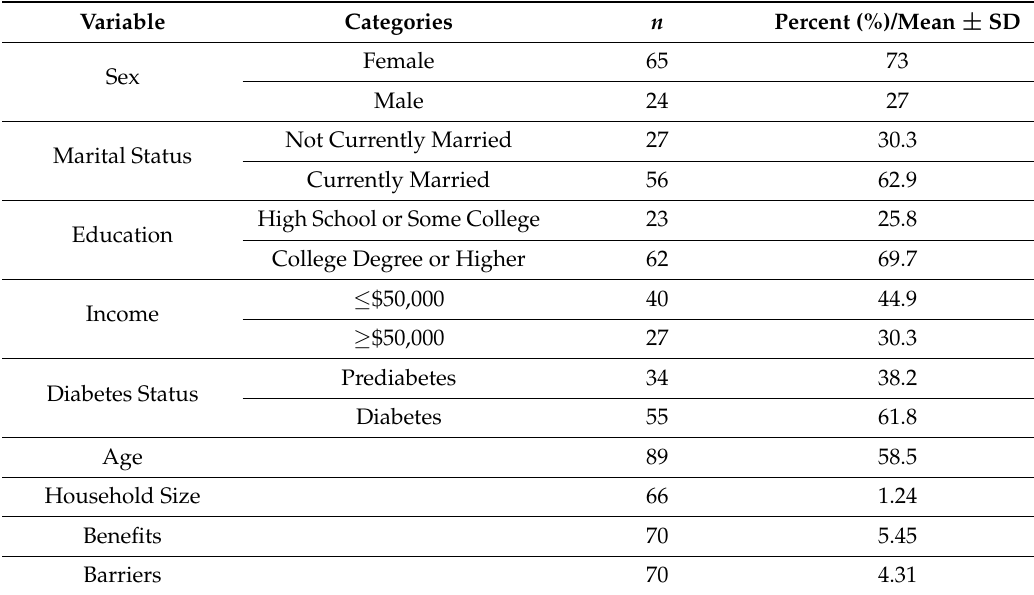
Table 1. Descriptive statistics of categorical and continuous, demographic